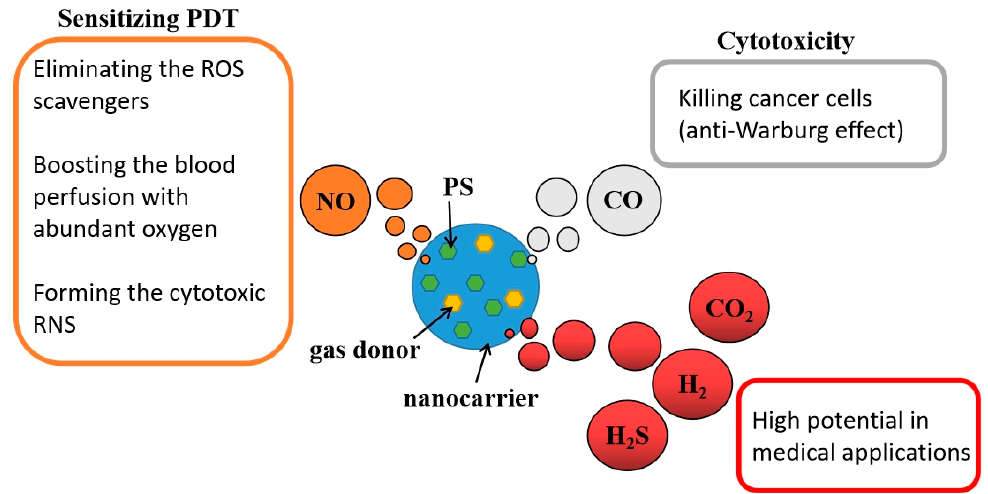
Figure 5. Various medical gases with unique functions could be delivered into the tumor site by nanocarriers to enhance PDT efficacy in tumor treatment.